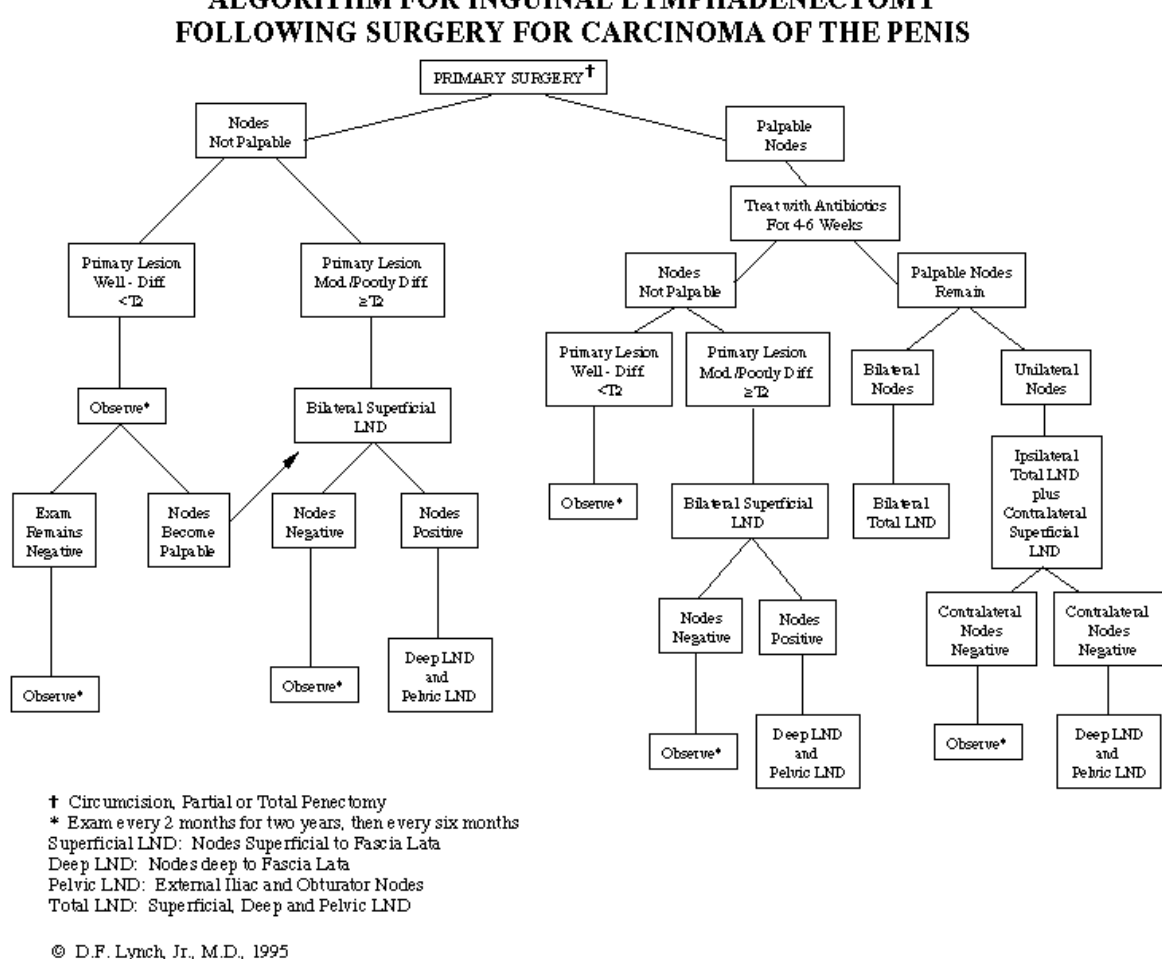
FIGURE 1 . Algorithm for inguinal lymphadenectomy. (From: Lynch DF, Schellhammer PF: Tumors of the Penis. In: Walsh PC, Retik AB, Stamey TA, Vaughan ED (eds): Campbell's Urology, 7th ed, Philadelphia, WB Saunders Co, 1996 (in press); with